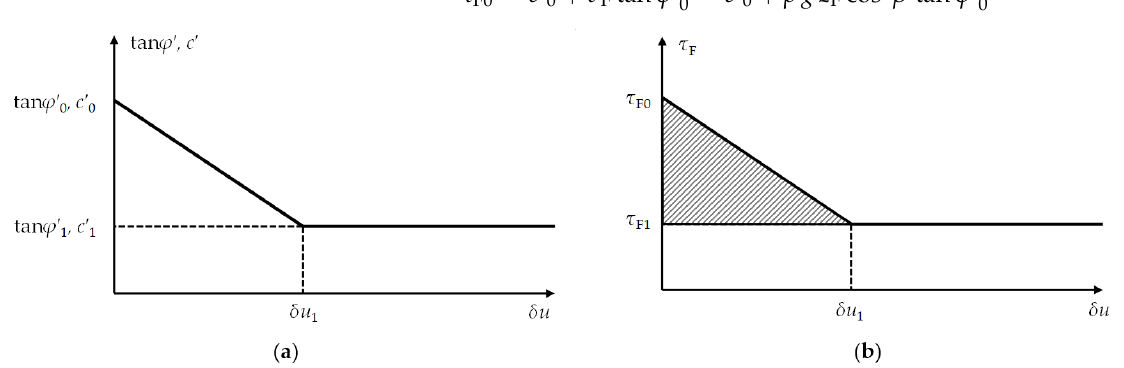
Figure 4. ( a ) Friction angle ϕ (cid:48) and cohesion c (cid:48) as a function of mobilization displacement δ u ; ( b ) Shear strength τ F as a function of mobilization displacement δ u